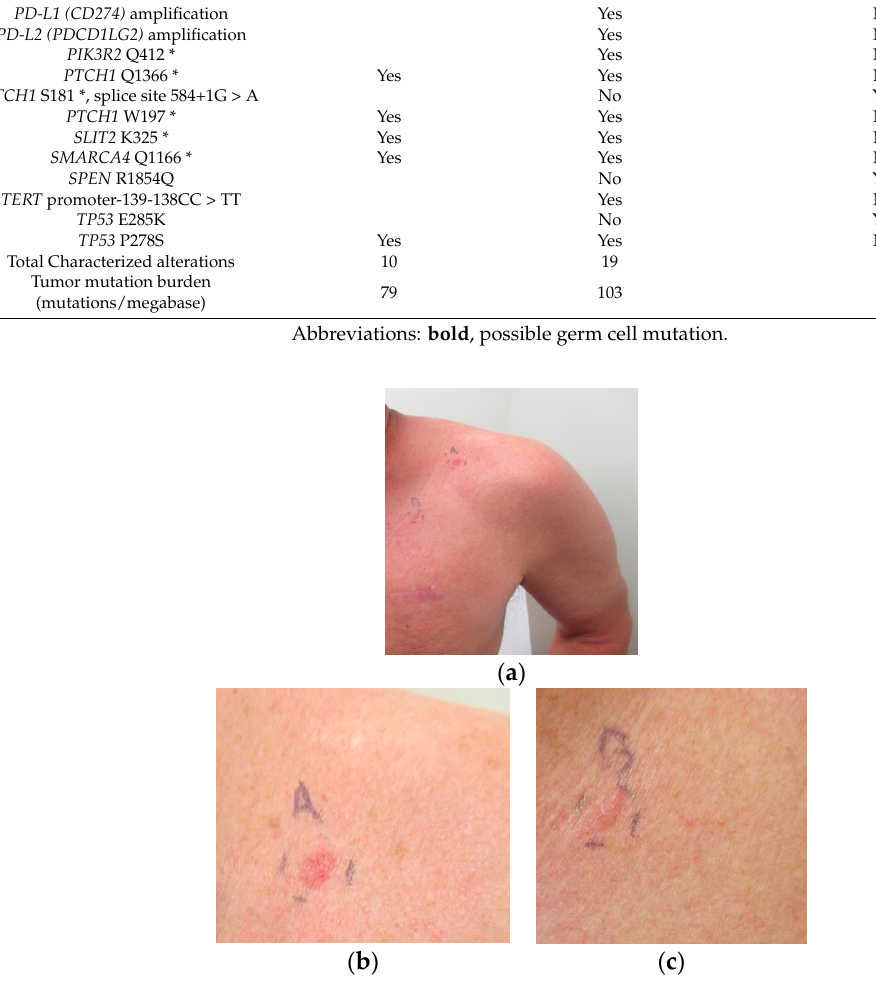
Figure 1. Superficial basal cell carcinomas presenting as erythematous plaques on the left anterior shoulder (labeled A) and the left chest (labeled B) in a man whose metastatic basal cell carcinoma is new primary skin cancers on the left anterior shoulder ( b ) and left chest ( c ) that developed while the patient’s metastatic basal cell carcinoma was responding to nivolumab. The patient gave signed informed consent for data analysis and the publication of the